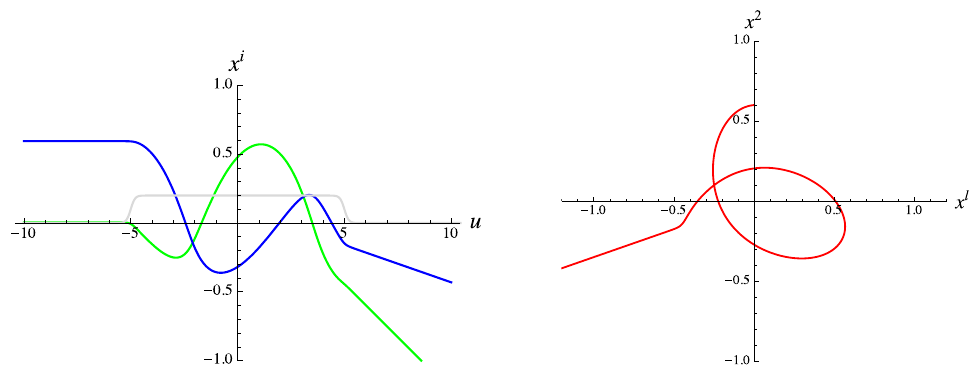
Figure 11 . The left-hand plot shows the behaviour of the transverse coordinates x 1 ( u ) (in green) and x 2 ( u ) (in blue) of a geodesic in the neighbourhood of (cid:13) through the passage of the gyraton, shown here with pro(cid:12)le (cid:31) F ( u ) = (cid:31) J ( u ) = (cid:2)( u; L ) with L = 10. Parameters are chosen such that the reference geodesic (cid:13) makes one orbit of the gyraton axis between u = (cid:0) 5 and u = 5. The right-hand plot shows this motion in the transverse ( x 1 ; x 2 )